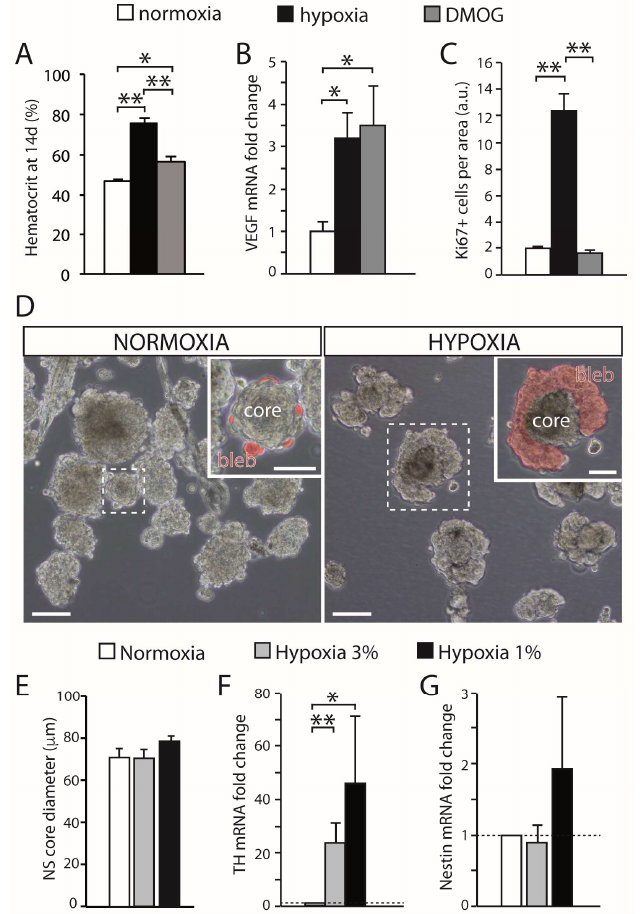
Figure 2. E ff ect of hypoxia on carotid body growth. ( A ) Quantification of the hematocrit in rats exposed to hypoxia (10% O 2 ) or maintained in a normal atmosphere and treated with DMOG for 14 days, in comparison with normoxic rats. Note that inhibition of prolyl hydroxylases with DMOG increased the hematocrit, although to a lesser extent than hypoxia. ( B ) Quantitative PCR showing the induction of VEGF, a HIF-dependent gene, in the brain of rats exposed to normoxia, hypoxia, or treated with DMOG. ( C ) Quantification of the density of Ki67-positive cells within the CB parenchyma of rats exposed to normoxia (21% O 2 ), hypoxia (10% O 2 ), or DMOG (21% O 2 ) for 3 days. DMOG did not increase cell proliferation in the CB despite the fact it induced HIF-dependent genes (3 rats per group). ( D ) Bright-field images of CB primary neurospheres cultured under normoxia (21% O2) or hypoxia (3% O2). Di ff erentiating blebs of TH-positive cells are pseudo-colored in red in the insets. Scale bars: 100 µ m (50 µ m in insets). ( E ) Quantification of neurosphere core diameter in cultures grown at di ff erent levels of hypoxia (6 cultures for normoxia and hypoxia 3% O 2 , and 3 cultures for hypoxia 1% O 2 ). ( F , G ) qPCR results showing relative expression of tyrosine hydroxylase (TH) and nestin in neurospheres at di ff erent levels of O 2 tension. The expression of TH significantly increased under hypoxia, whereas nestin expression showed a non-significant variability ( n = 7 cultures in normoxia and hypoxia 3% O 2 ; 4 cultures for hypoxia 1% O 2 ). Error bars are SEM. * p < 0.05; ** p < 0.01. Modified from [35] .